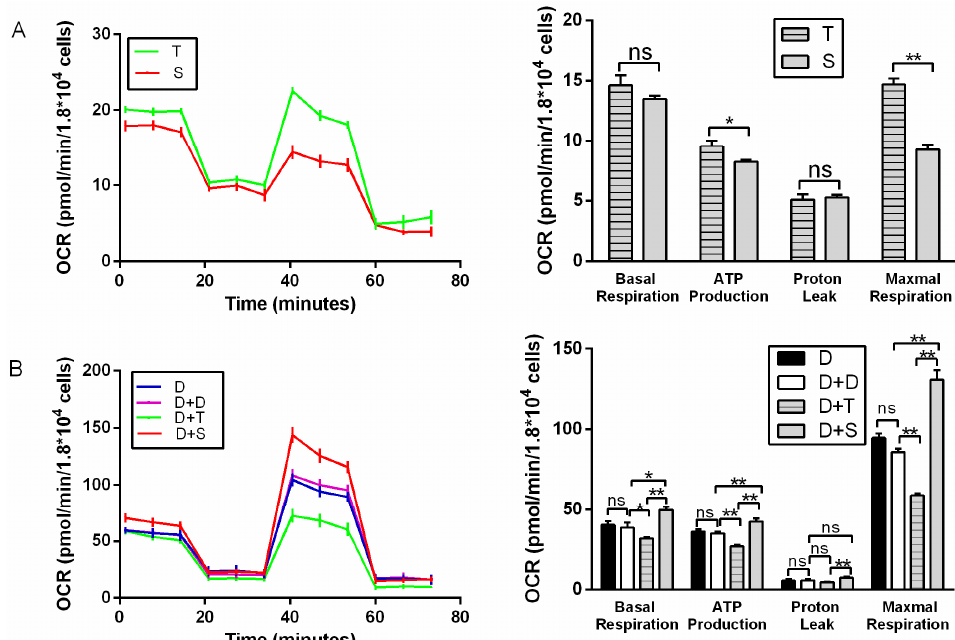
Figure 2. Mitochondrial stress test for primary chicken cells and cybrids. ( A ) Illustrating OCR of primary cell lines (T, S). ( B ) Illustrating OCR of cybrid cells; D was used as a control for D + D. Oligomycin, FCCP, and rotenone plus antimycin A were injected sequentially to the cells. OCR profiles were expressed as pmole O2 / min / 1.8 × 10 4 cells. In cybrid cells, the acronym D denotes a common nucleus of DF-1 cell, and + T and + S represent the source of mitochondria. n = 6 per group. * means p < 0.05, ** means p < 0.01, and ns means p >